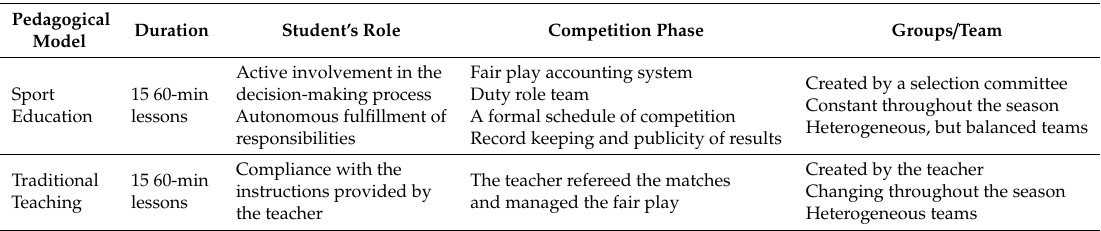
Table 1. Main features for the implementation of sports education and traditional